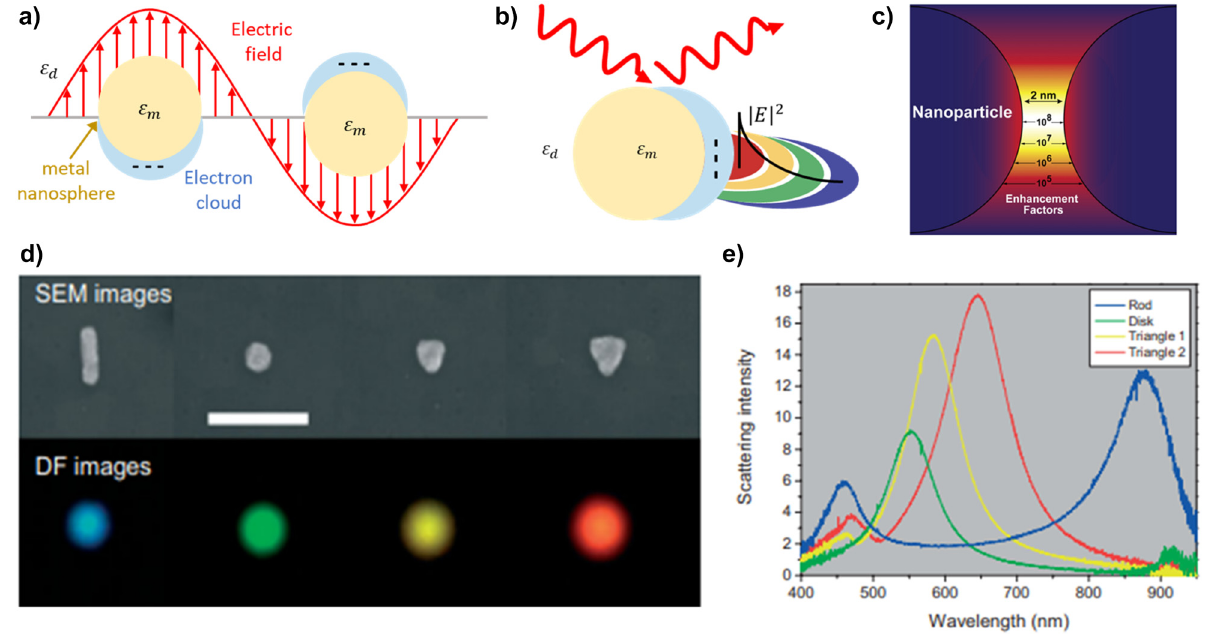
Figure 2: The formation process and characteristics of LSPR. (a) Formation of LSPR in metallic nanospheres. LSPR is effectively generated when the conduction band electrons in the metal nanosphere oscillate in phase with the incident electric field. (b) Schematic of the electric field distribution near the metal nanosphere; the LSPR induced electricfieldexponentiallydecaysfromthesurfaceofthenanosphere.(c)Schematicofthehotspotbetweennanoparticledimersshowingthe dramatically enhanced local EM fields. Adapted with permission from ref. [72]. Copyright 2011, Elsevier. (d) Several geometrical types of metallic nanoparticles, upper panel: SEM images, lower panel: dark fi eld (DF) images, (e) scattering spectrum of each nanoparticle